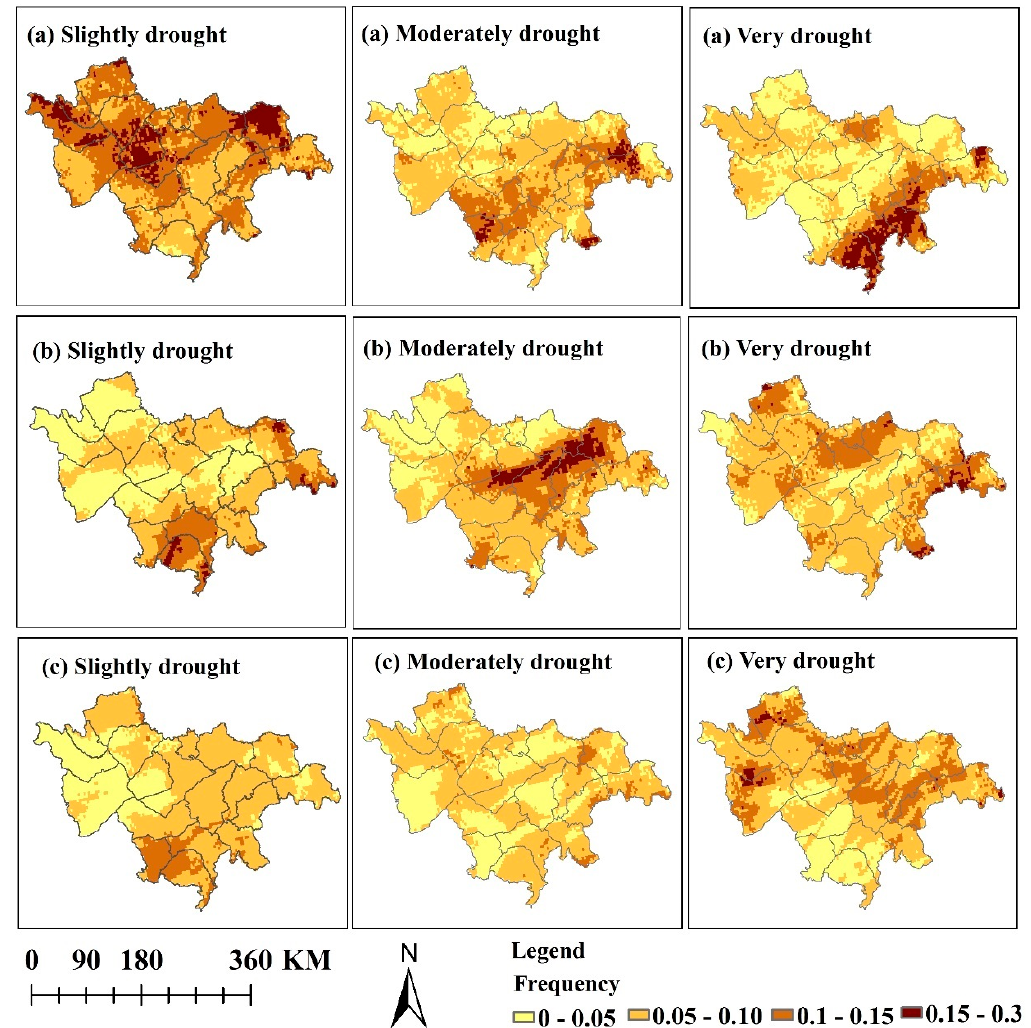
Figure 8. Spatial pattern of frequency of different drought grades based on the CDWI from 1982 to 2015 at different stages in Midwestern Jilin Province. ( a – c ) represent the stages of emergence-tasseling, tasseling-milky maturity, and milky maturity-mature, respectively.